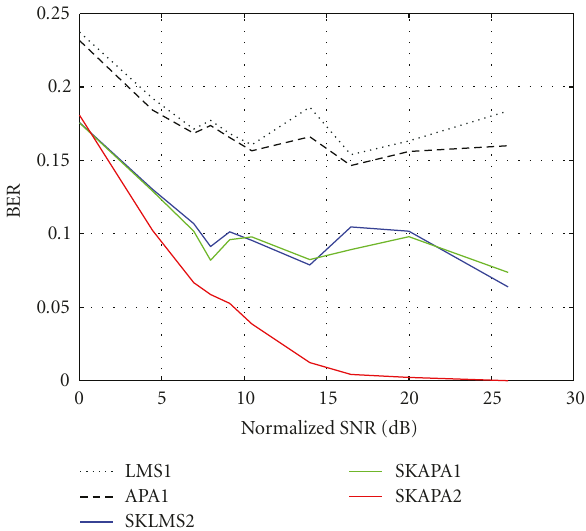
Figure 10: Network size over training in the nonlinear channel equalization with an abrupt change at iteration